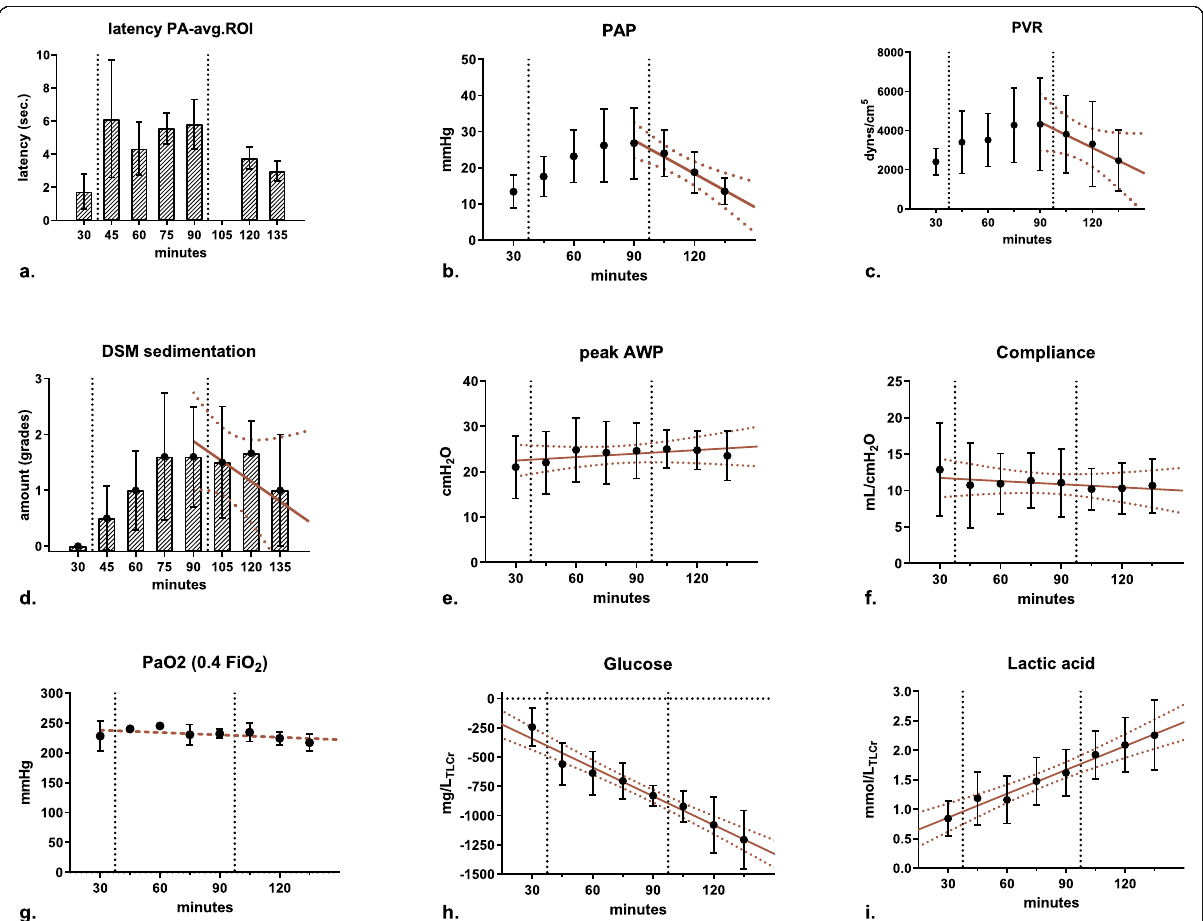
Fig. 7 Recorded parameters during isolated lung perfusion. The first dashed vertical line in each graph indicates the first transpulmonary embolisation. The second vertical line indicates the administration of 500 units of alpha-amylase. Red solid lines indicate the linear regression line and red dashed lines represent the confidence band. avg.ROI Average to regions of interest, AWP Airway pressure, DSM Degradable starch microspheres, PA Pulmonary artery, PaO 2 Partial pressure oxygen, PAP Pulmonary arterial pressure, PVR Pulmonary vascular resistance. x axis values given in min